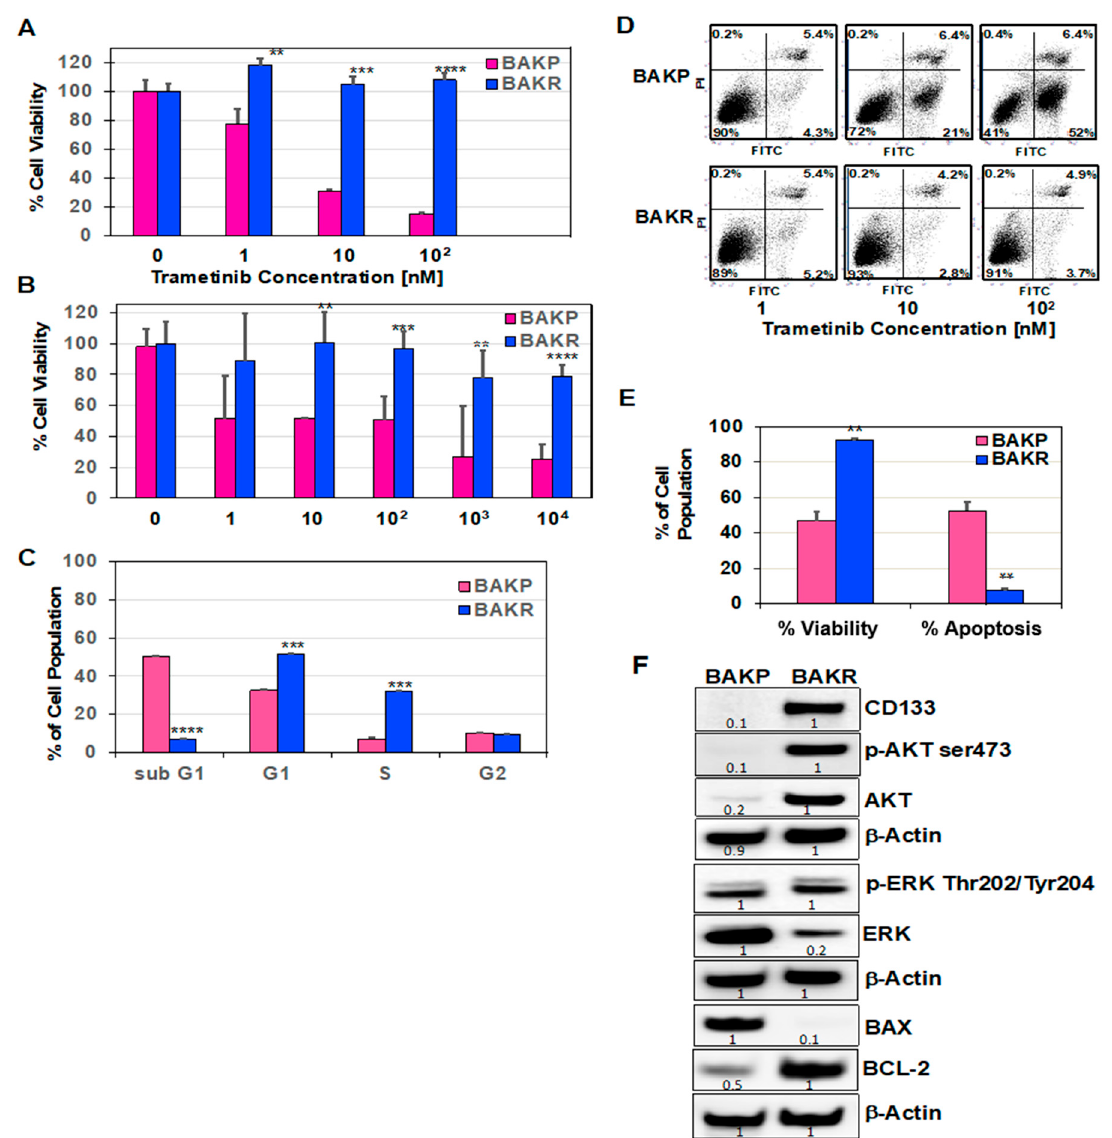
Figure 1. Sustained CD133 overexpression in BAKR cells increases cell viability and resistance to trametinib- and DTIC-induced apoptosis. CD133(+) BAKR melanoma cells and parental BAKP cells were exposed to increasing doses of trametinib ( A ) or DTIC ( B ) for 72 h, followed by XTT cell via- bility assays to assess drug sensitivity. ( C ) Cell cycle analysis of BAKR and BAKP cells after treat- ment with 100 nM trametinib for 72 h. ( D ) Representative dot plots of cells treated with indicated doses of trametinib and subjected to Annexin-FITC/PI staining and flow cytometry; and ( E ) % cell viability and apoptosis of cells in D. ( F ) Basal expression levels of pro-survival or pro-apoptotic proteins were compared in BAKP and BAKR cells by immunoblot analysis with antibodies to CD133, activated p-AKT (ser473), AKT, p-ERK (Thr202/Tyr204), ERK, BCL-2, BAX, and β -actin as loading control. Densitometric analysis comparing intensities of protein bands relative to bands with the highest intensity is shown in immunoblots. Scans of whole gel immunoblots for all Figures are shown in “Supplementary Materials” (Figure S1). Results shown are the means ± SD of three replicates of a representative experiment; essentially the same results were obtained in three inde- pendent experiments. **, ***, **** represent p < 0.01, p < 0.001, and p < 0.0001, respectively. To elucidate possible mechanisms for the differential responses, AKT and ERK sur- vival pathways, as well as basal expression of anti-apoptotic BCL-2 and pro-apoptotic BCL-2-associated X protein (BAX) was assessed by immunoblot analysis. BAX is a key